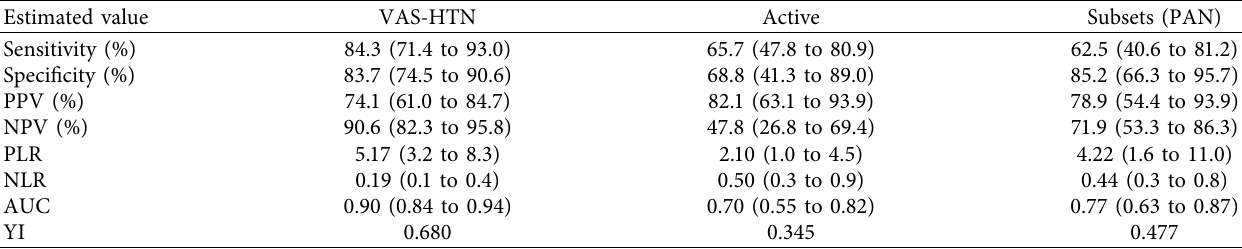
Table 4: Estimated value of serum anti-LAMP-2 antibody levels based on the